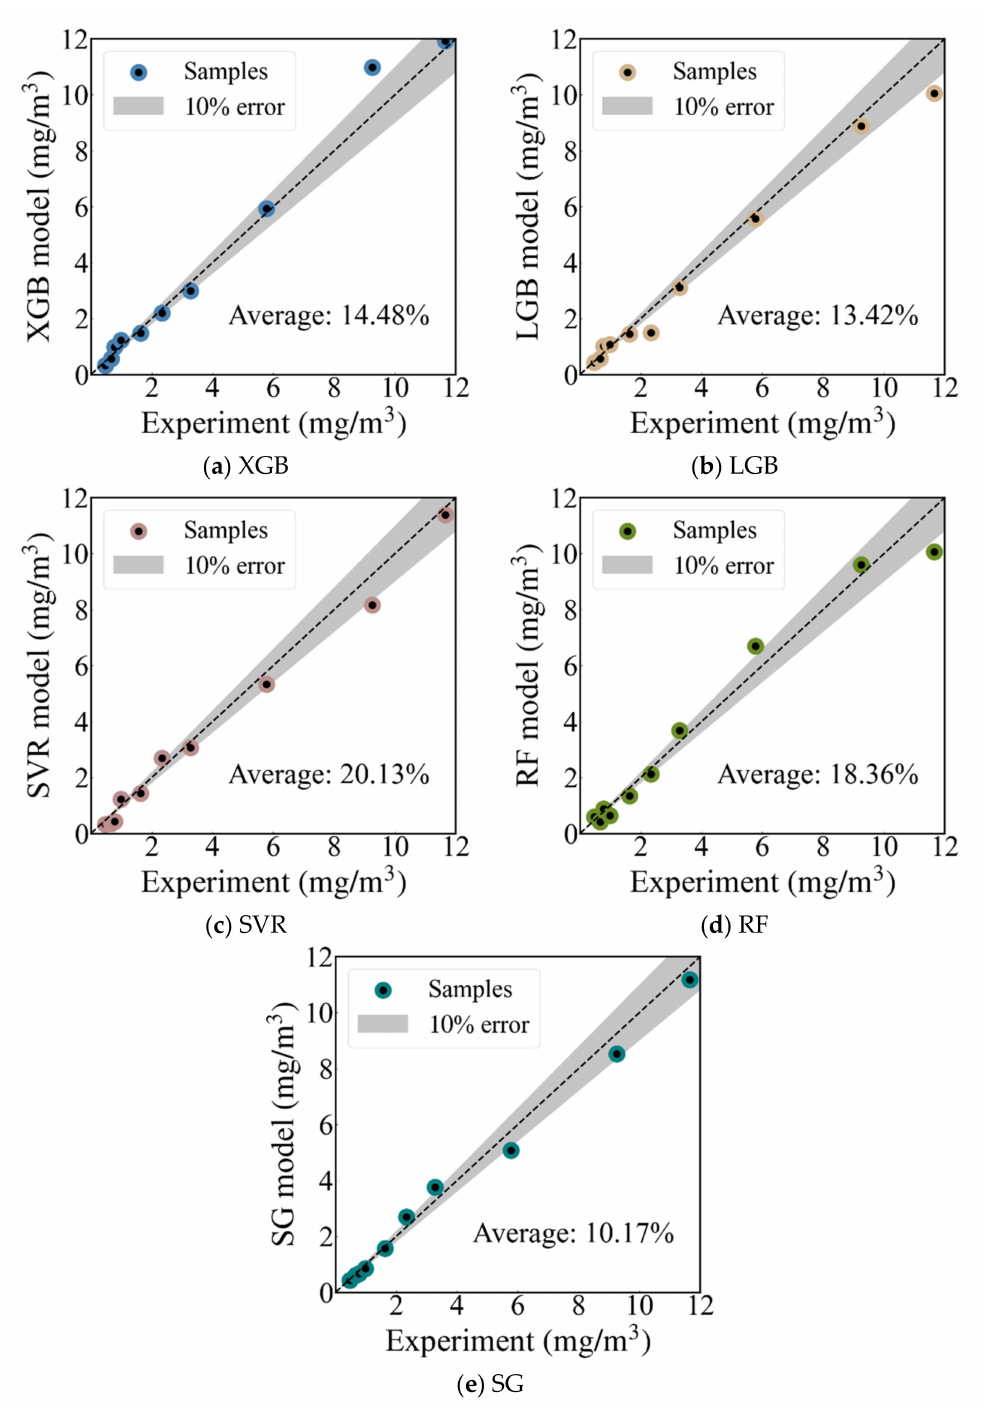
Figure 15. Prediction results of each model on validation